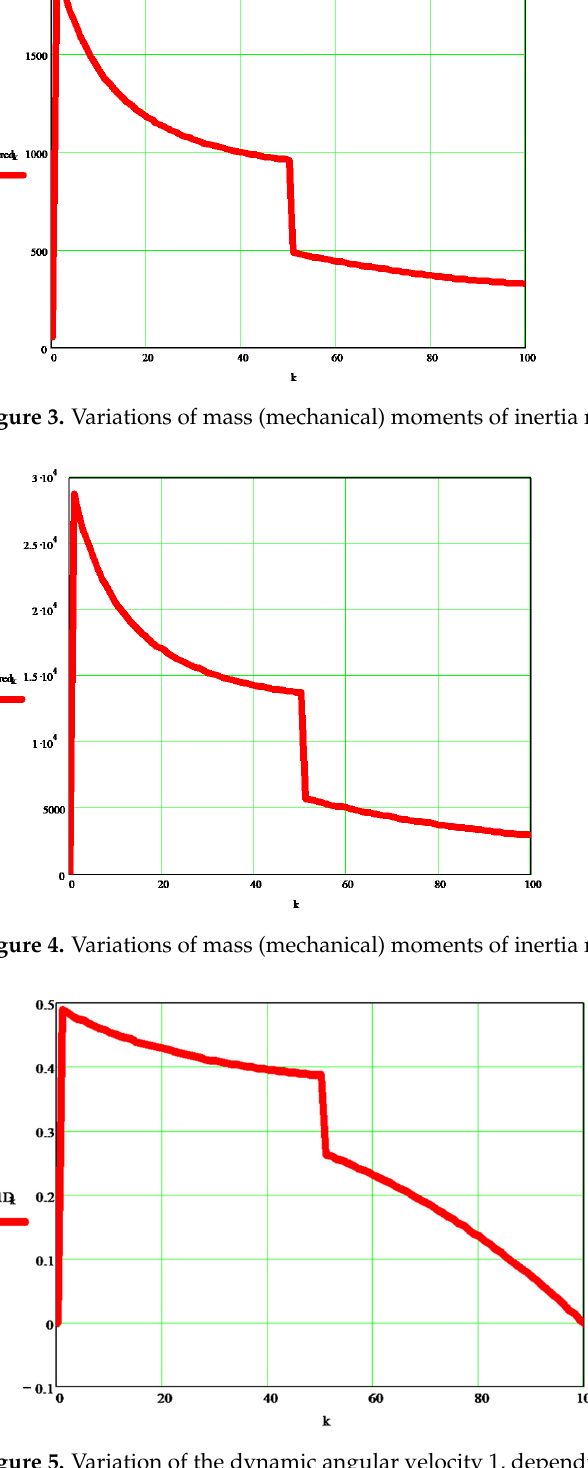
Figure 5. Variation of the dynamic angular velocity 1, depending on the independent parameter k .